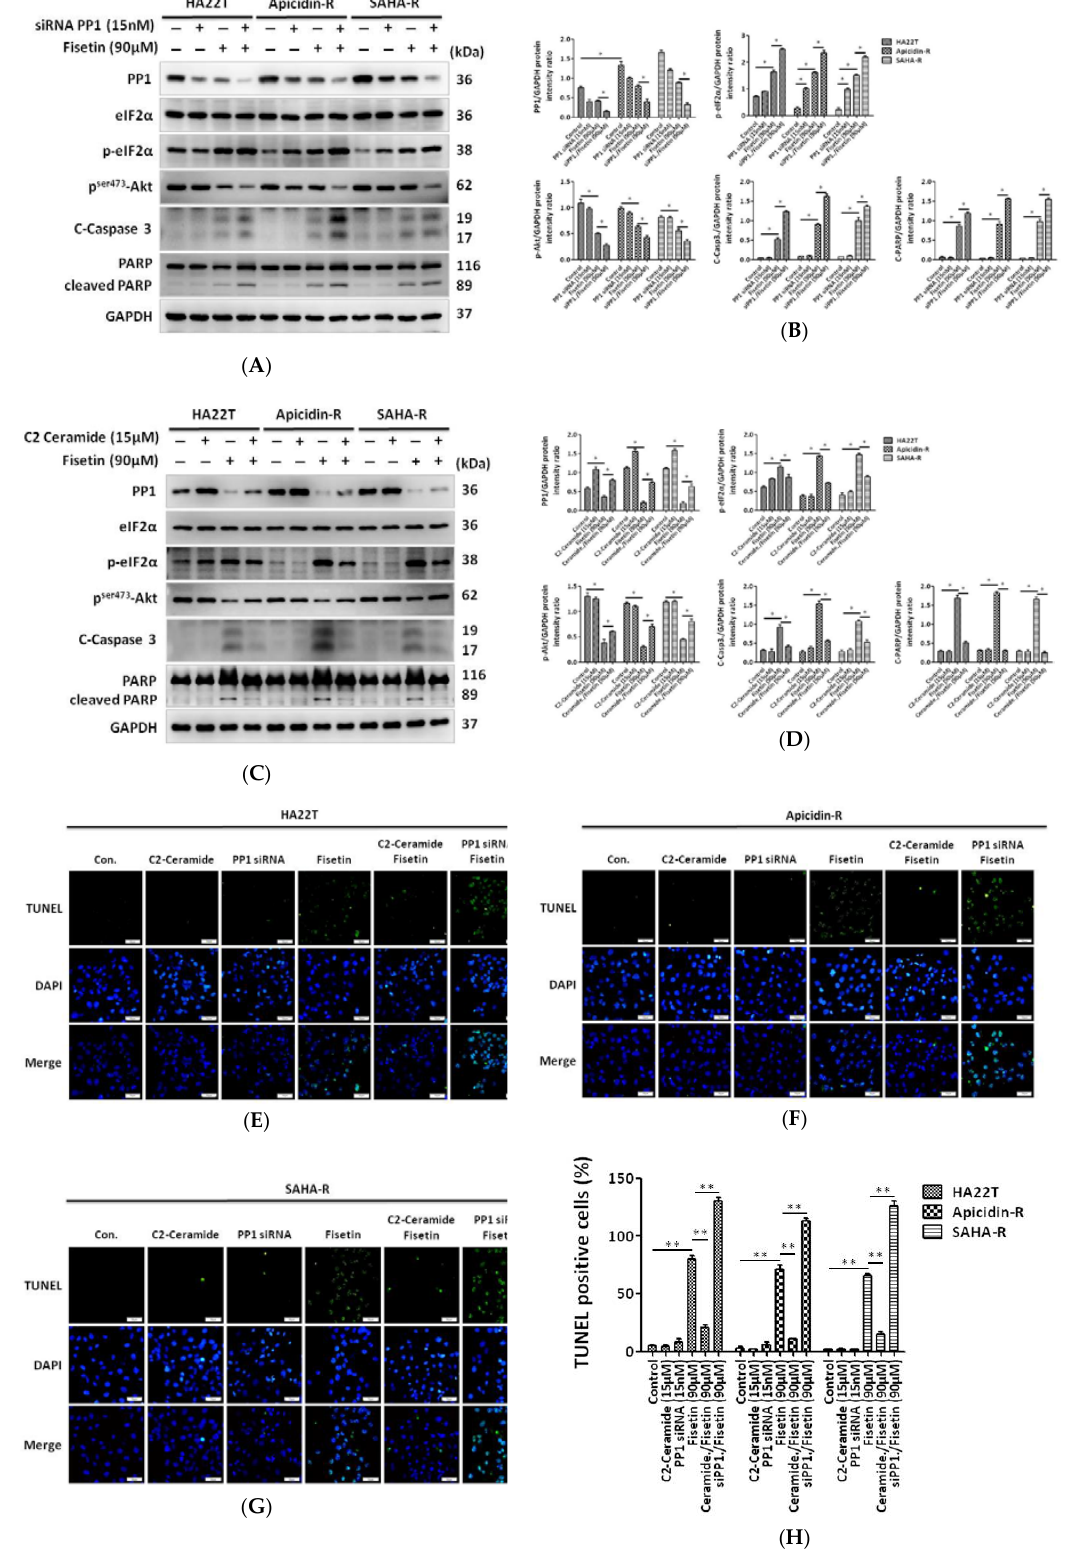
Figure 5. Role of PP1 in the in vitro death of liver cancer cells ( A , B ) Downregulation of PP1 expressed by siRNA induced HCC cell apoptosis by fisetin. Western blot quantification using the ImageJ software, normalized to